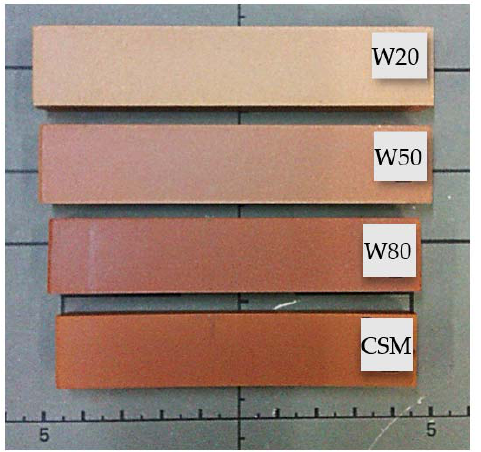
Figure 6. Ceramics’ hue variation in relation to CSM content. Transition from ochre-white to reddish color with increase in CSM.